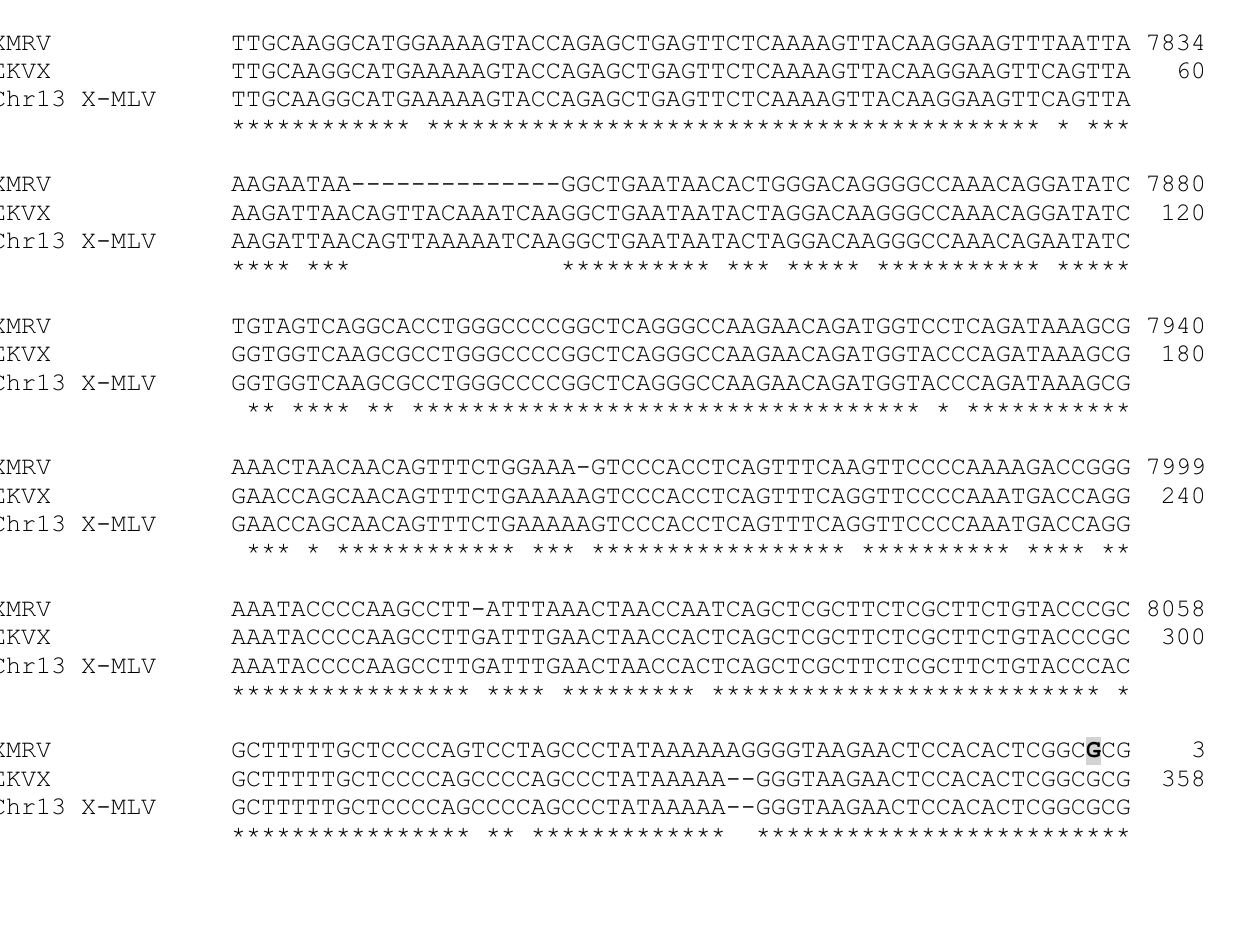
Figure 3. Nucleotide sequence from the LTR, gag , and env regions of the EKVX virus. The sequences of regions of the EKVX virus are aligned with XMRV (VP62; accession no. DQ399707) and an endogenous X-MLV provirus from chromosome 13 (Chr13 X- MLV) of a C57BL/6 mouse (accession no. CT030655, nt 54,685-63,371). U3 sequence from the 3  end of XMRV VP62 sequence was appended to the 5  end in the figure to generate the predicted provirus sequence. Numbering for XMRV is according to XMRV VP62, with nt 1 (at the U3/R transition) highlighted in gray. Numbering for EKVX indicates the nucleotide number for each fragment shown. Conserved nucleotides are indicated by *. (A) LTR- gag leader region, compiled from PCR fragments generated with primers DG-75 7762F/DG-75 287R and DG-75 7945F/DG-75 664R. The primer binding site is underlined and shown in blue. The upstream glyco-Gag start is highlighted in green, and the in-frame stop codon in XMRV is shown in red. The start codon for the Gag polyprotein is highlighted in yellow. (B) env region, generated with primers VP62 5922F / VP62 6454R. (C) env -LTR region, generated with primers DG-75 7607F/DG-75 7968R. The stop codon for the Env polyprotein is shown in